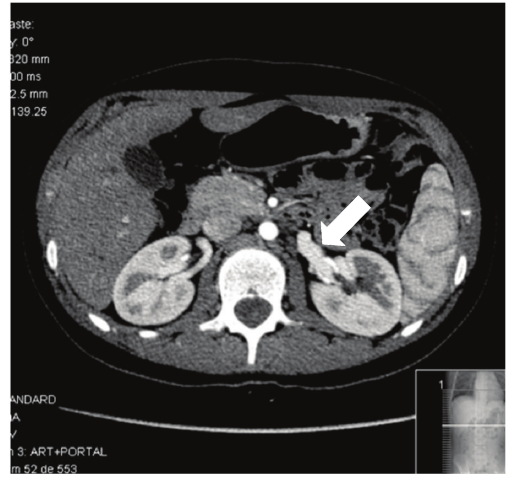
Figure 2: Enlarged left renal